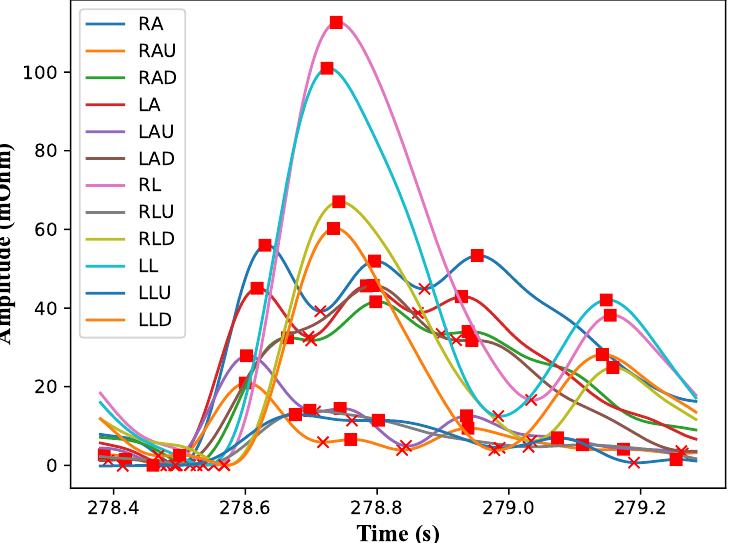
Figure 6. Signals in all channels after the completion of the processing process (Subject 1, Interval 300,